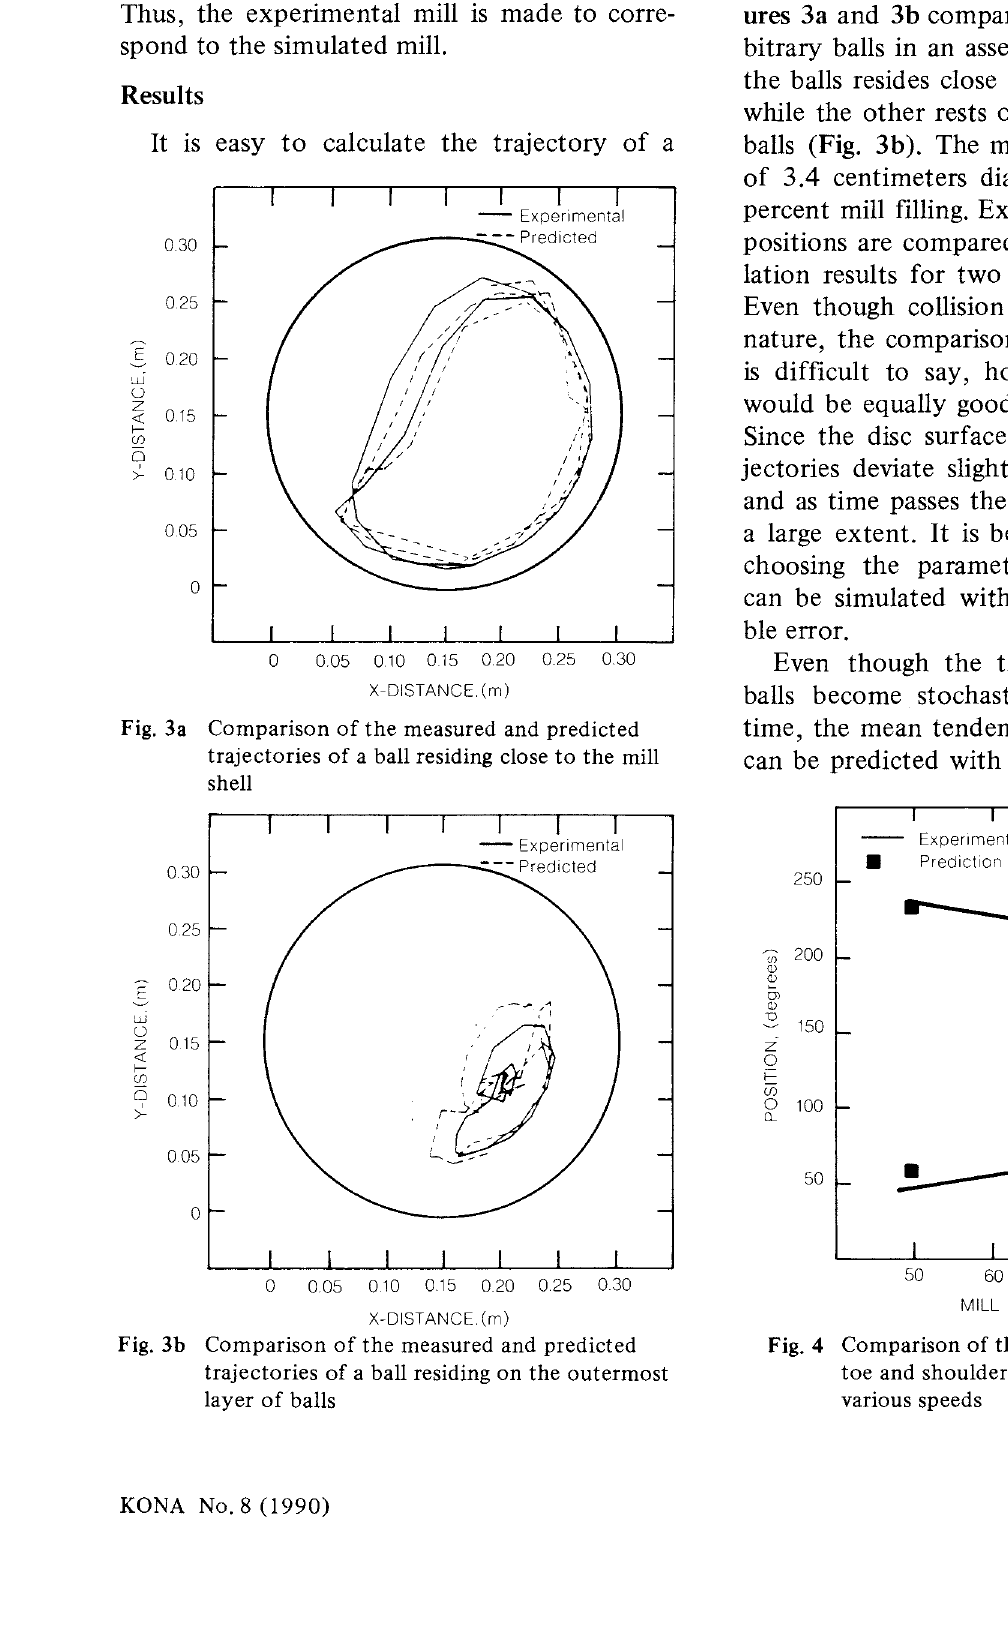
Fig. 3b Comparison of the measured and predicted trajectories of a ball residing on the outermost layer of balls